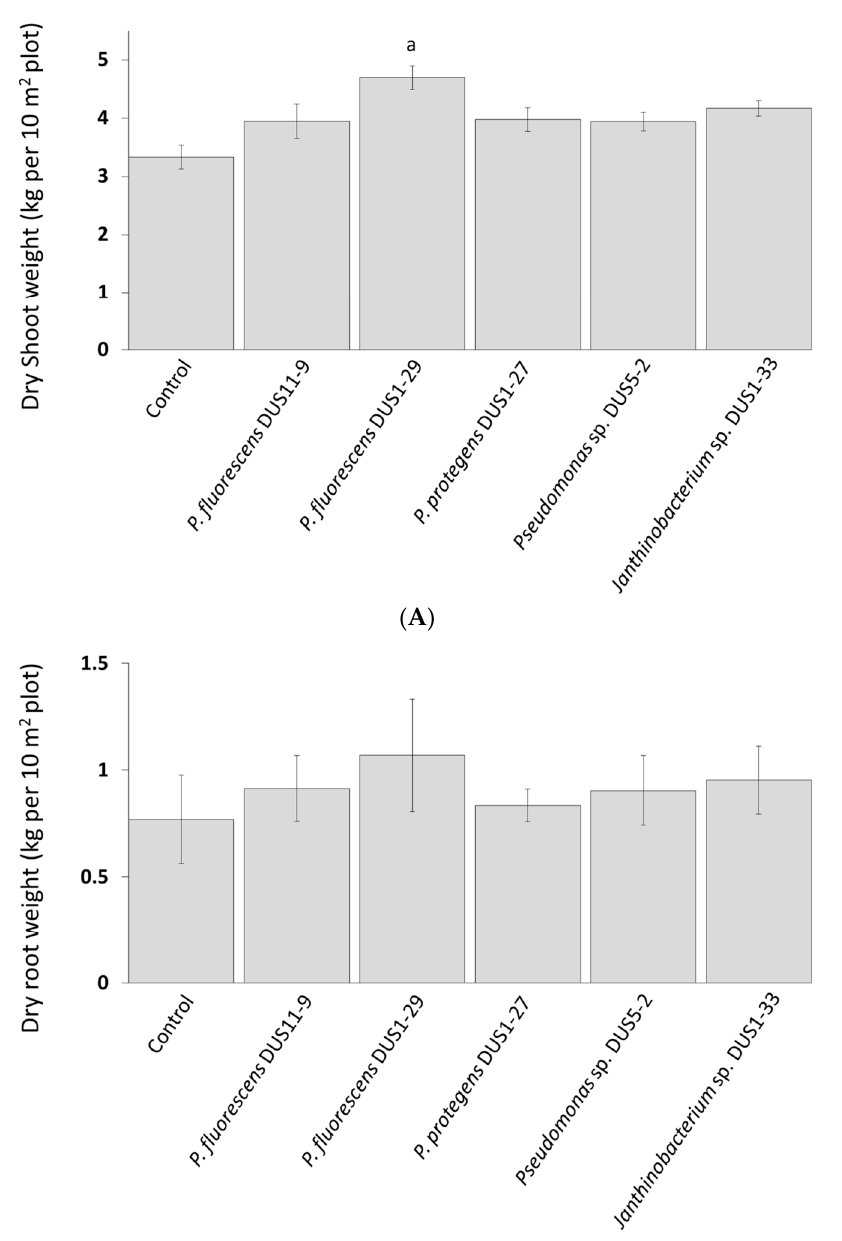
Figure 8. Field trial assessment of PGP effect of bacterial isolates on plants after 91 days of growth based on dry shoot ( A ) and dry root ( B ) biomass from triplicate 10 m 2 plots for each treatment. For each strain, 1 × 10 3 CFU of each strain was added when seeds were sown. Bacterial strains that significantly ( p < 0.05) increase dry shoot biomass for plants inoculated with P. fluorescens DUS1-29 to uninoculated control plants or plants inoculated with other strains is denoted by an “a”.